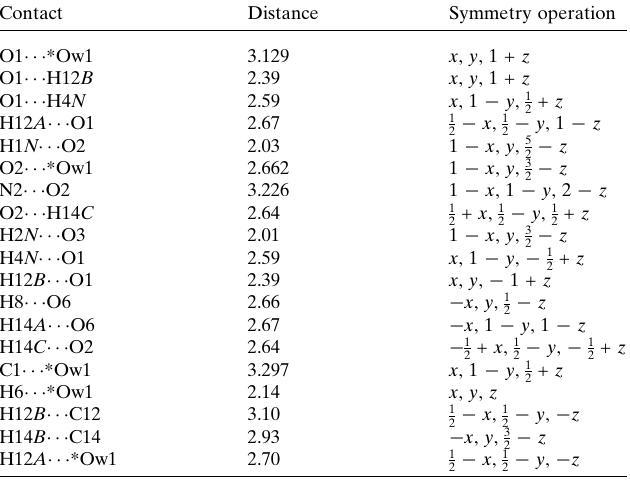
Table 2 Summary of short interatomic contacts (A˚ ) in the title compound. Contact